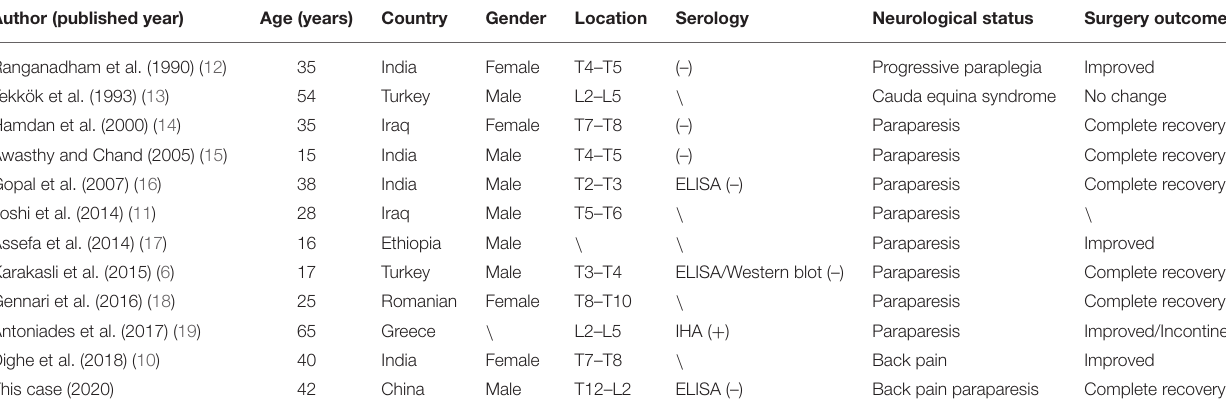
TABLE 1 | Details of all published cases of primary extradural intraspinal together with paravertebral hydatid